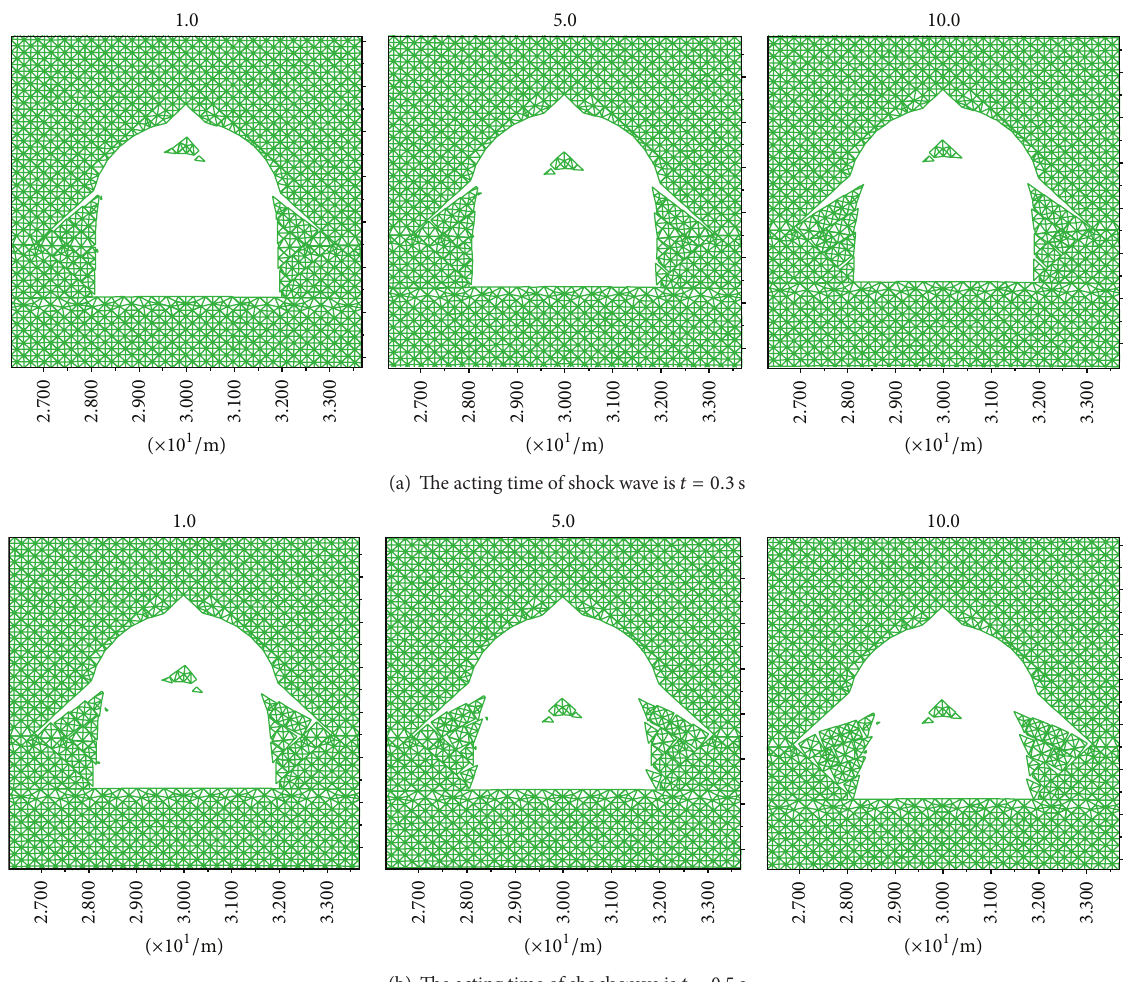
Figure 9: Rockburst failure of roadway at 𝑡 = 0.3 s and 0.5 s of shock wave acting time. Note: the numbers of 1.0, 5.0, and 10.0 m represent the multiple of the original uniaxial tensile strength of immediate roof,